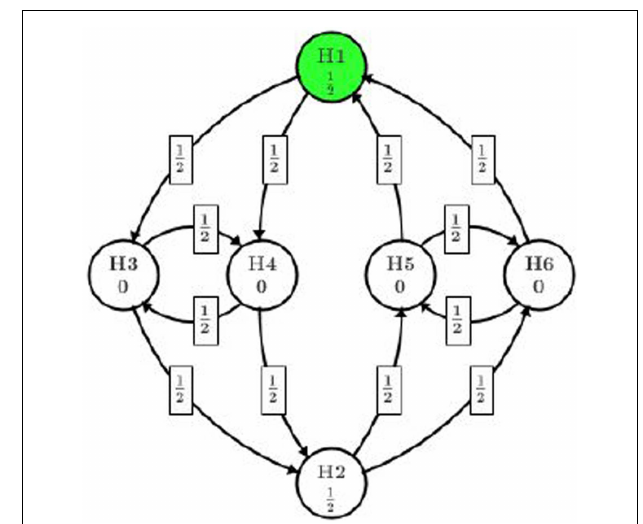
FIGURE 3 | Reuse alpha among dose levels